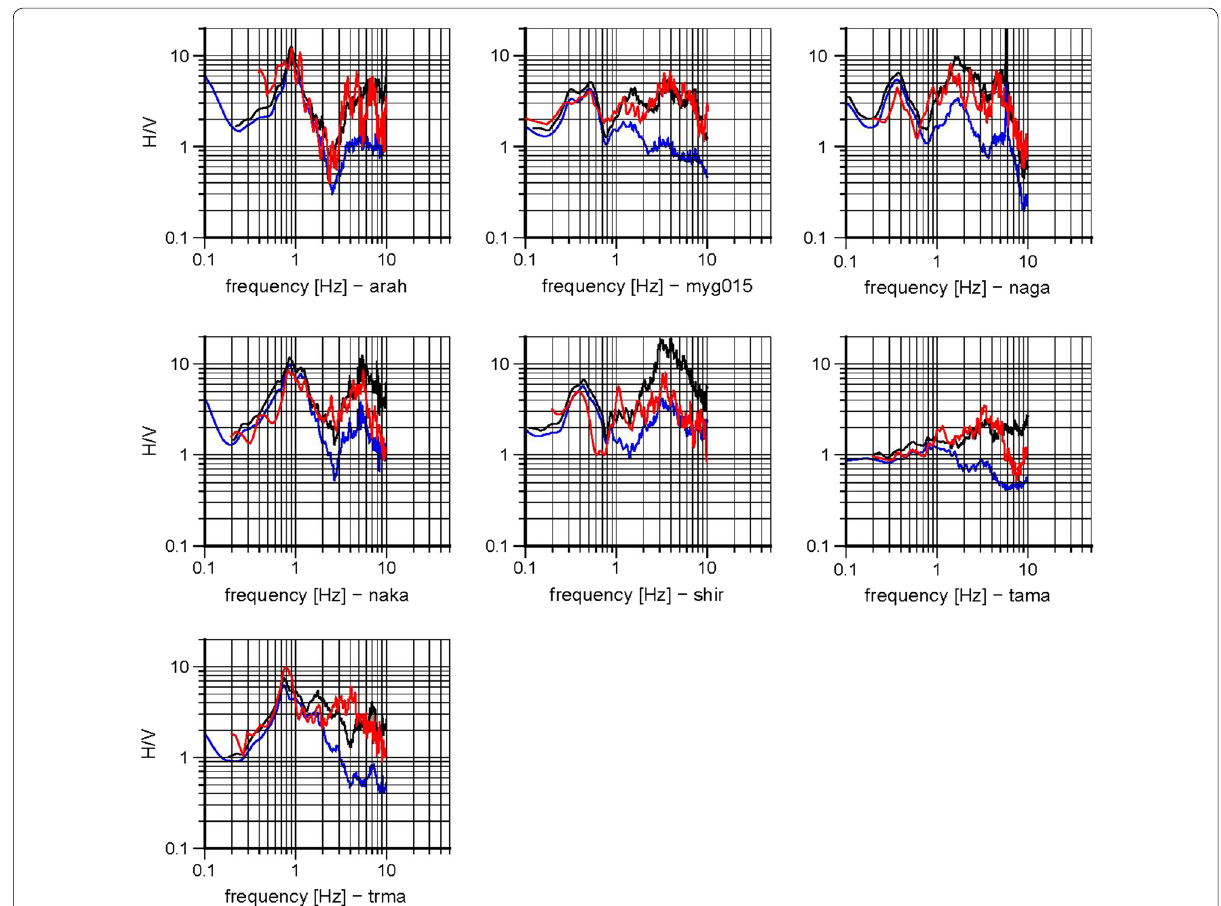
Fig. 19 Comparison of EHVRs (red), MHVR (blue), and pEHVR (black) at seven sites in